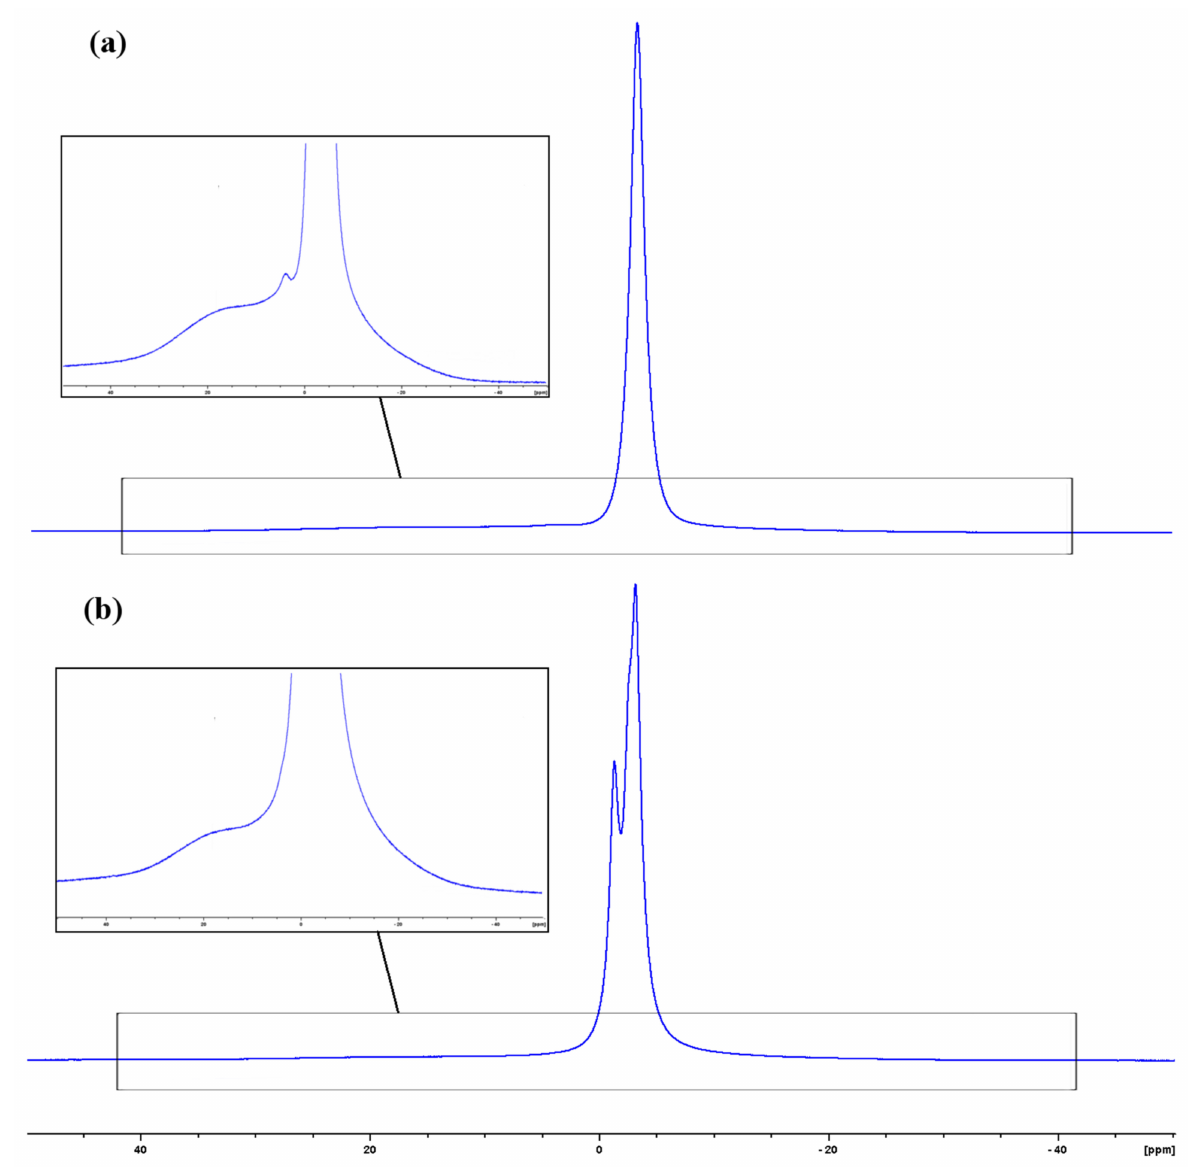
Figure 5. 1 H solid state NMR of IV ( a ) and V ( b ). The inset shows an expansion of spectrum footing. The solid state 1 H NMR spectrum of oligomer III contains mostly rigid components (Figure 7). However, the presence of mobile components allows us to calculate the fraction of defects (silanols) in these oligomers, which is less than 10%. Hence, we synthesized multiblock-copolymers with a complex rigid–soft structure with defect units containing silanol